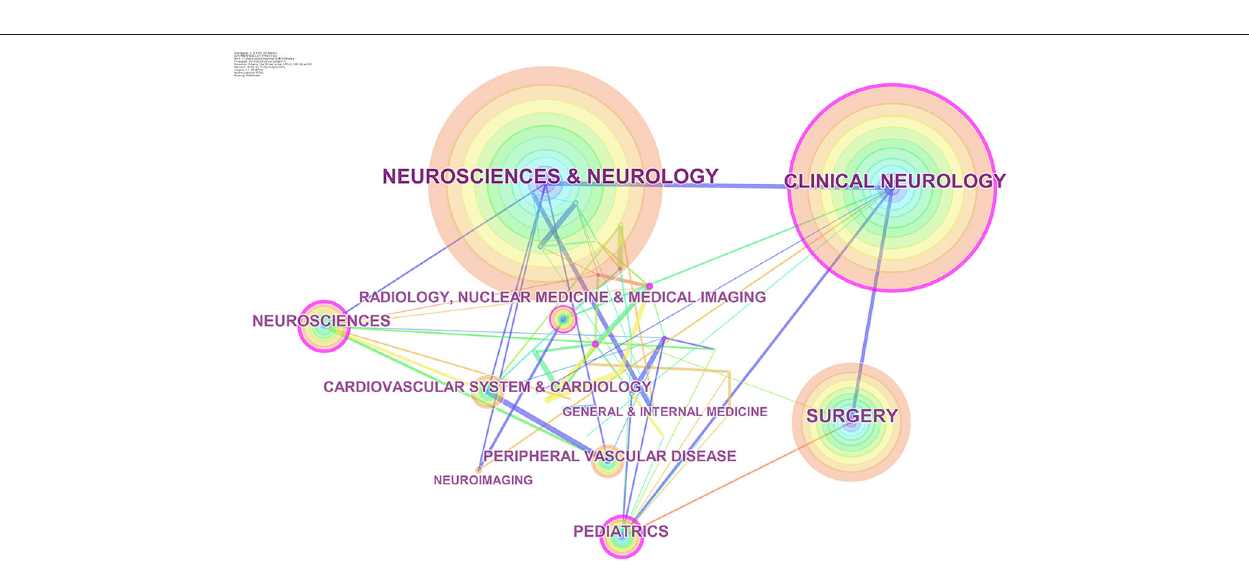
FIGURE 6 | The visualization map of subject categories on MMA. The tree ring-shaped nodes represented different subject categories. The lines between two nodes meant co-occurrence. The area of the nodes referred to the number of publications. Nodes with high centrality (purple ring) were deemed as the hot